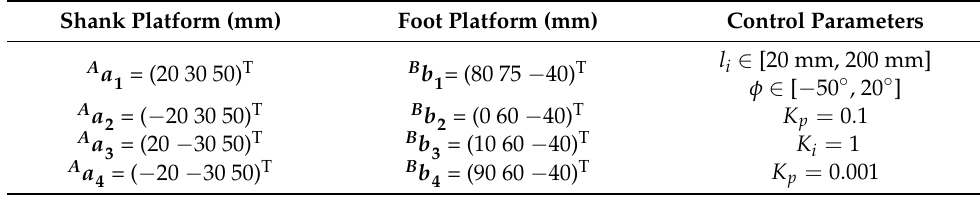
Table 2. Parameters of performance evaluation for the control design.